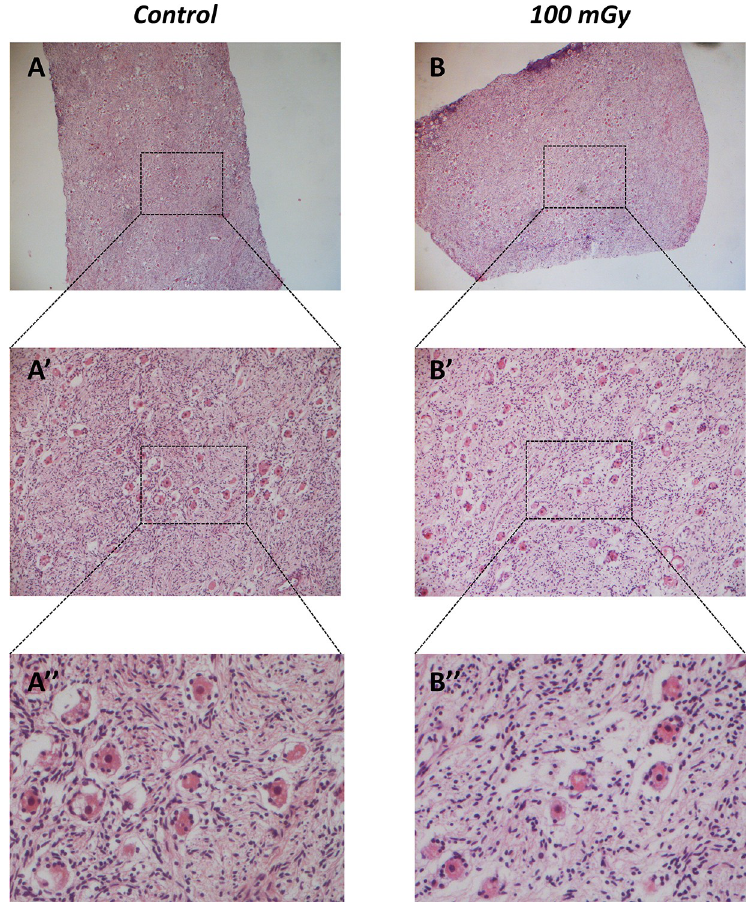
Fig 5. Histological analysis of human ovarian cortex after treatment with/out low-dose of X-ray radiations. Representative hematoxylin-eosin-stained sections from control (A) and 100 mGy treated ovarian cortex (B). A’-A” and B’-B” are higher magnification images from A and B respectively.